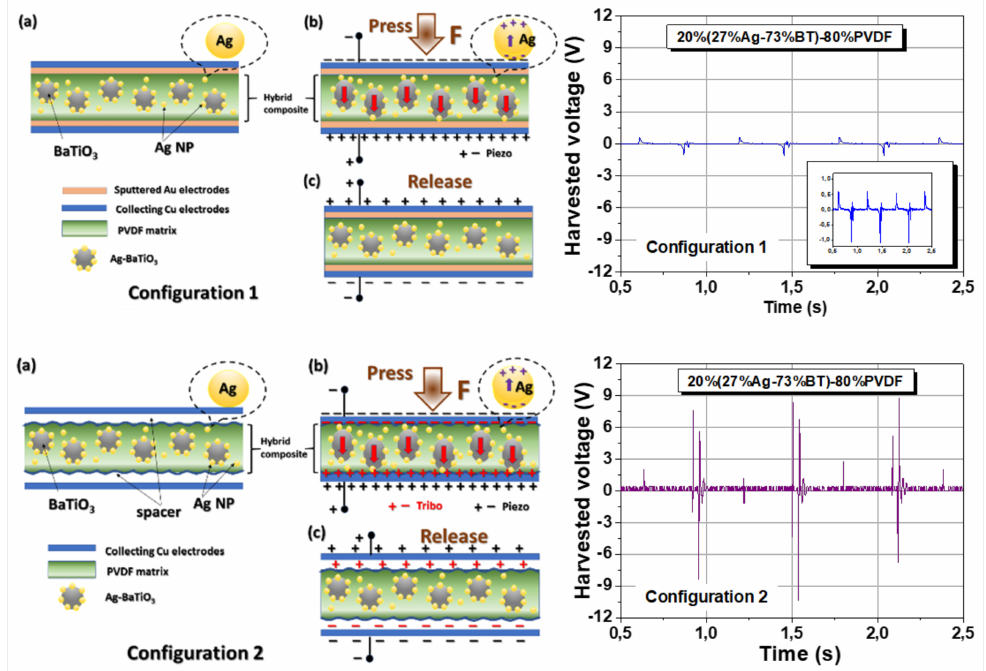
Figure 8. Schematic representation of the mechanical energy harvesting experiments in two con- figurations: Configuration 1 ( a – c ) when the flexible film is placed inside the collecting capacitive device in contact with the collecting Cu electrodes, and Configuration 2 ( a – c ) when not electrode plated composite thick film is freely placed inside the collecting electrodes. The proposed mechanism Configuration 1 and 2 of the mechanical energy harvesting ( left ) and their corresponding voltage outputs measured in open circuit conditions ( right ).